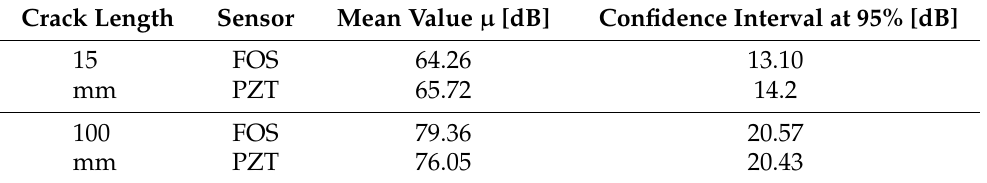
Table 3. The mean value and critical value at 95% for the FOS- and PZT-collected energies. Crack